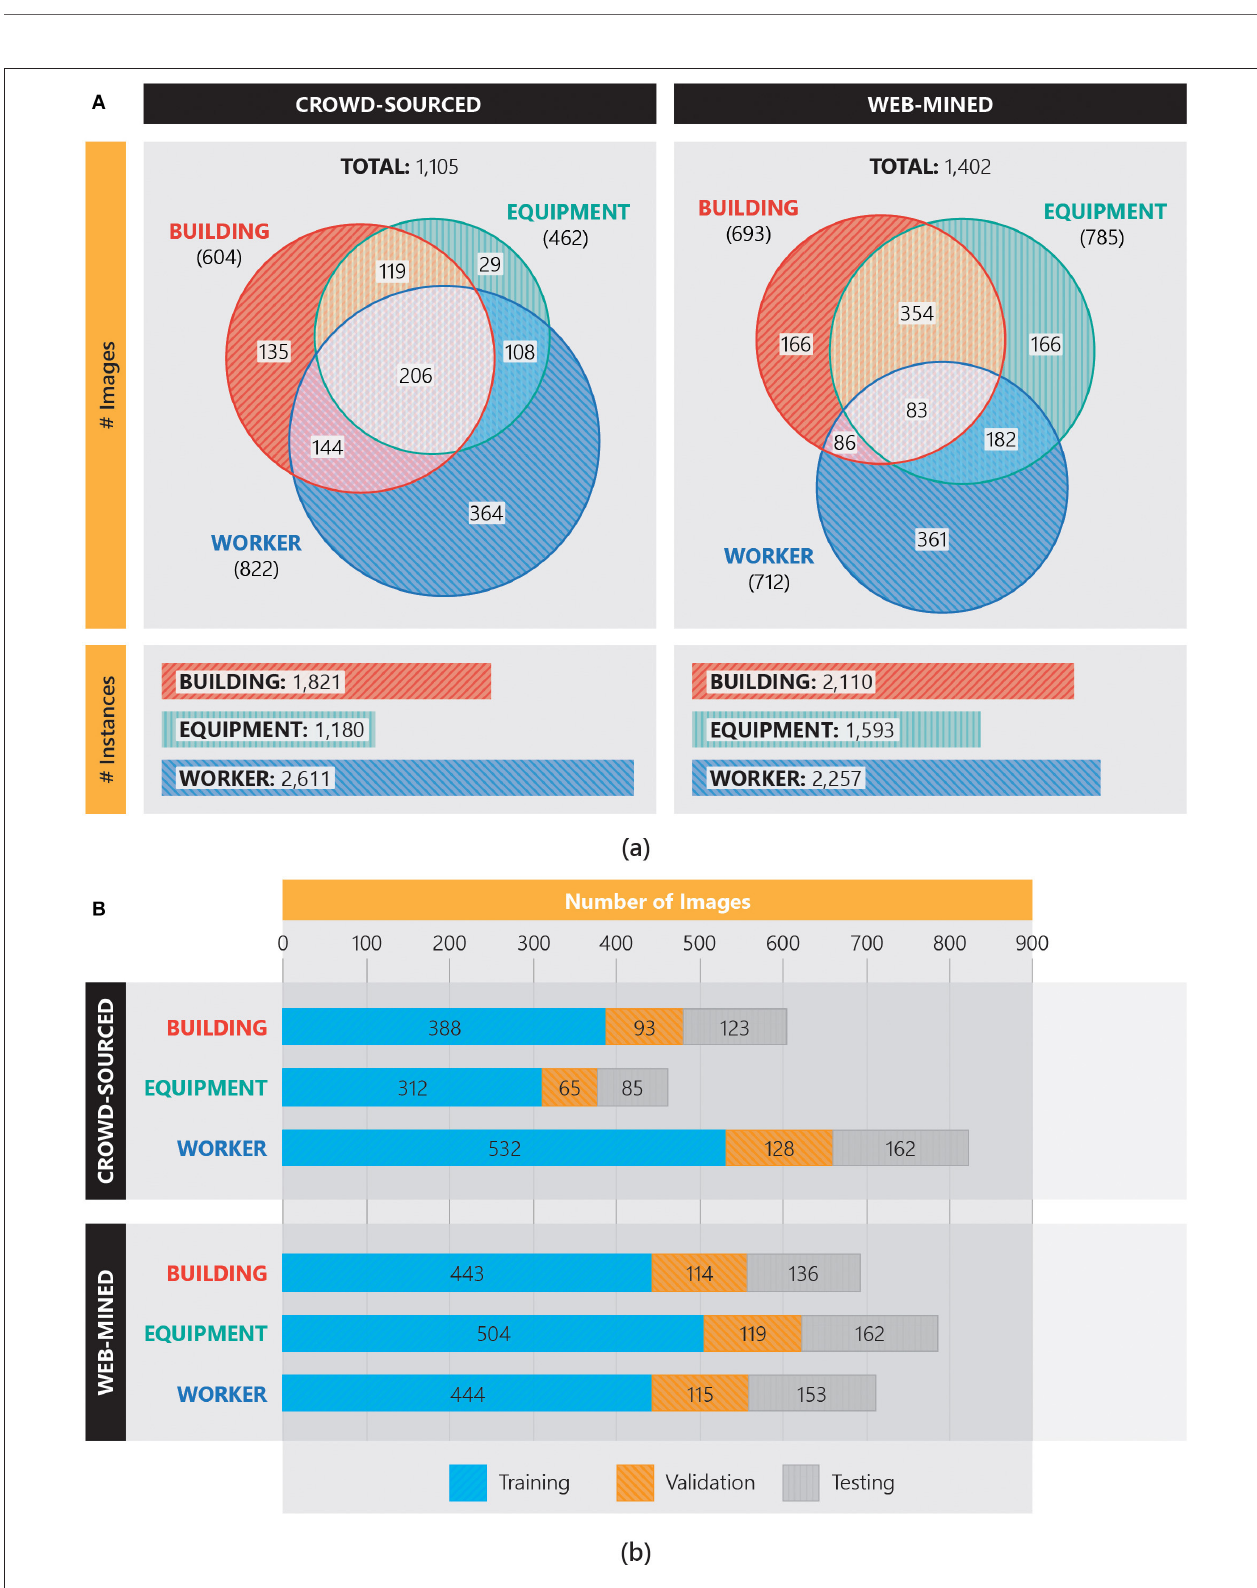
FIGURE 3 | Number of images (A) per class labels retrieved through crowdsourcing and web-mining in the Pictor-v2 dataset, and (B) in the training, validation, and testing datasets.